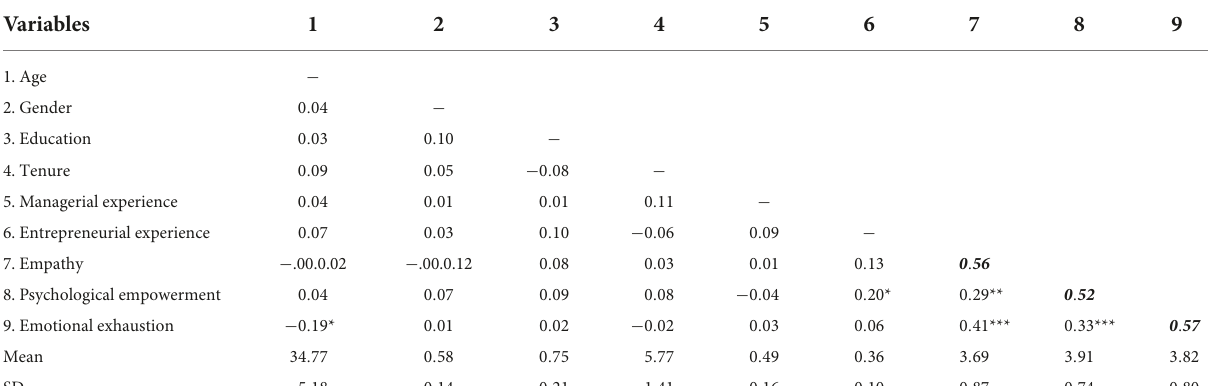
TABLE 1 Correlation matrix of all variables.